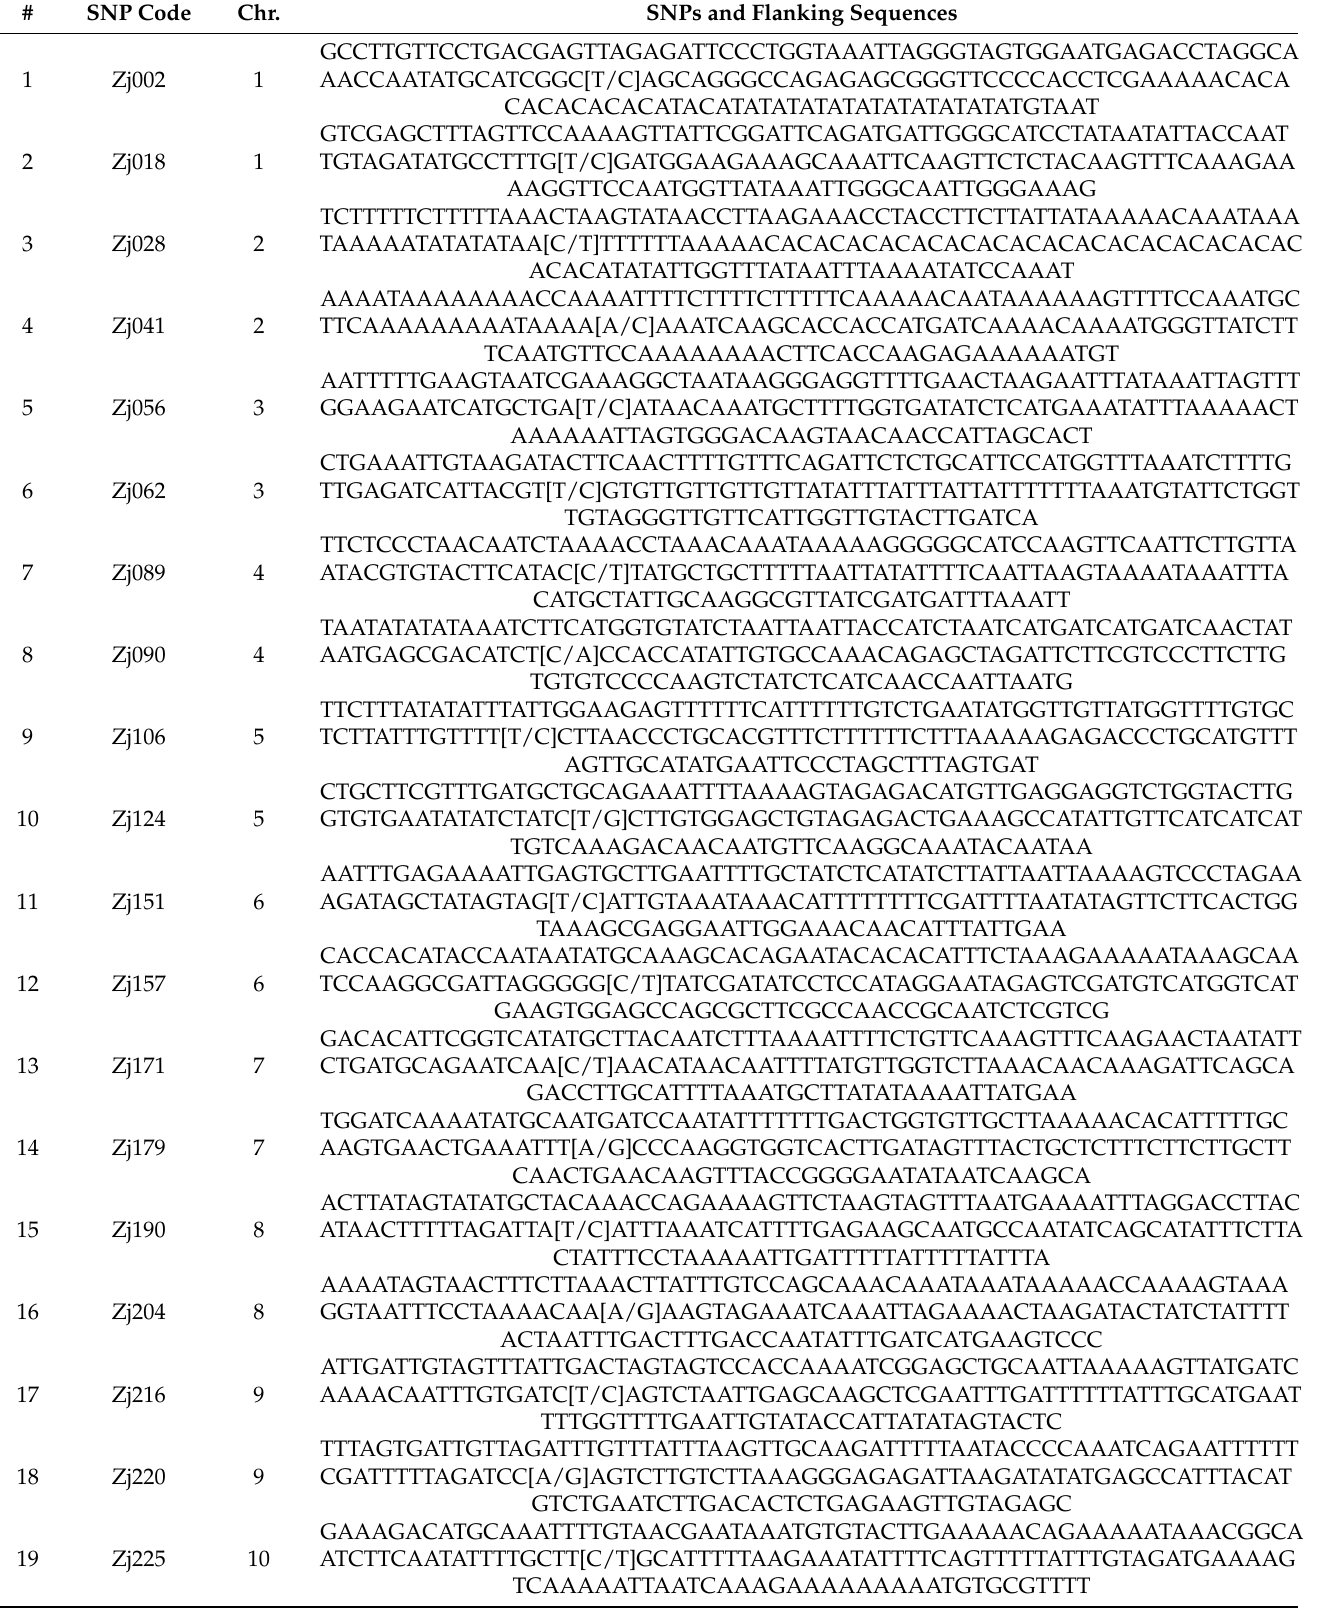
Table 2. The top 24 selected SNP markers recommended as a genotyping kit for jujube fruit authenti- cation. The full panel of 96 markers was listed in Supplementary Table